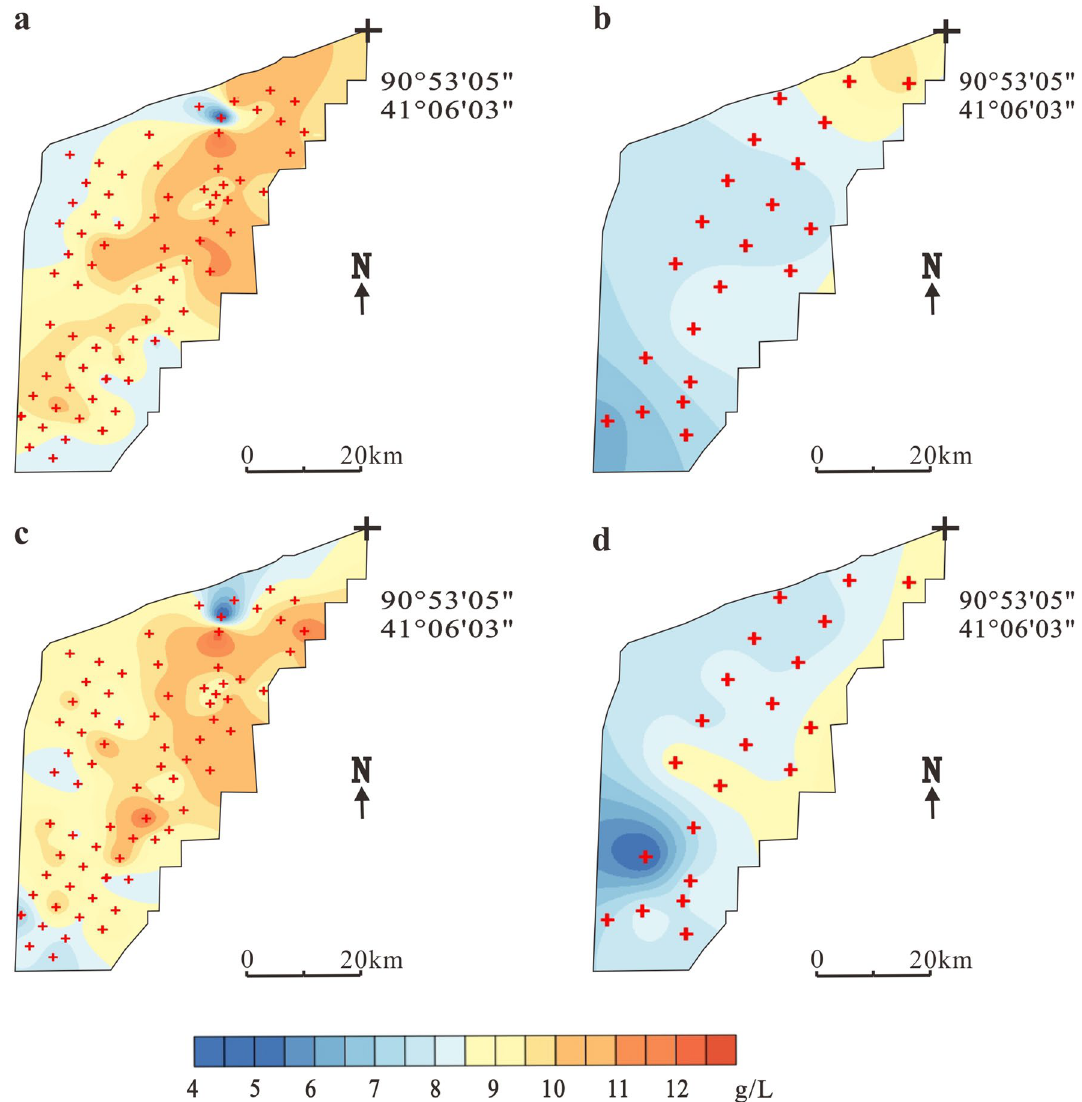
Figure 8. Temporal and spatial variations in K + content of different brine layers in Xinqing platform. ( a ) Layer W 2 in 2010, ( b ) Layer W 2 in 2017, ( c ) Layer W 3 in 2010 and ( d ) Layer W 3 in 2017. The red crosses indicate observation holes